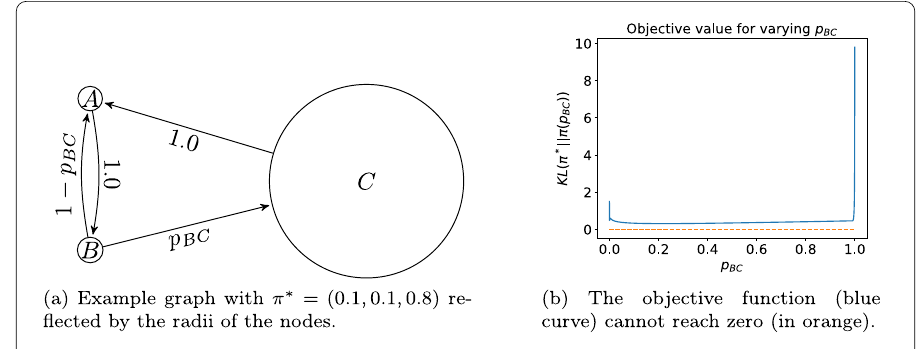
Figure 3 Illustration of a problem for which no perfect solution